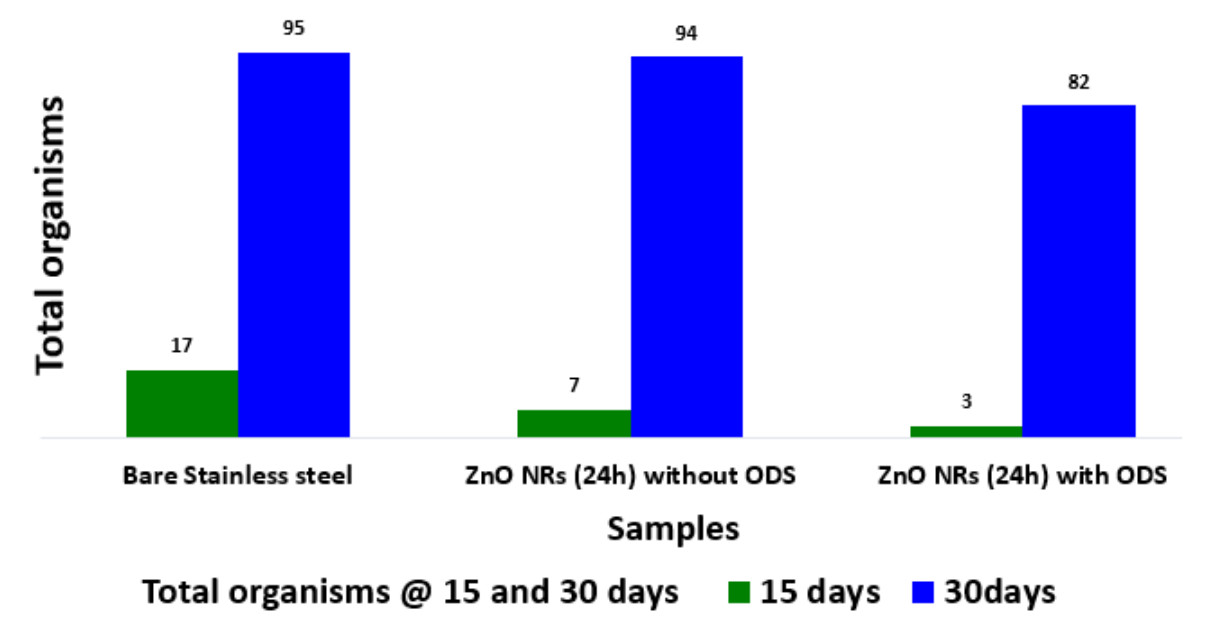
Figure 12. Total organisms attached to untreated stainless steel, ZnO nanorods after 24 h of growth modified and not modified with ODS.